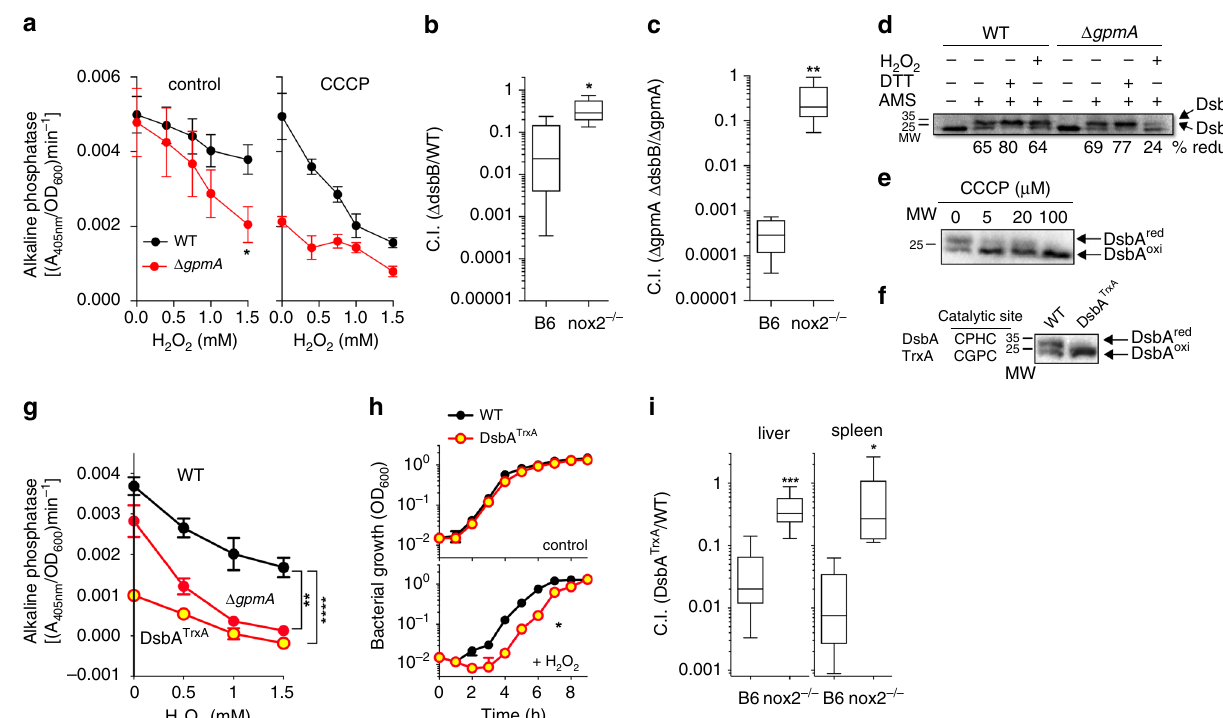
Fig. 4 Glycolysis facilitates folding of oxidized periplasmic proteins. a Alkaline phosphatase in Salmonella treated for 30 min with either 400 μ M H 2 O 2 or 20 μ M CCCP. Mean± SD; N = 6. b , c C57BL/6 (B6) and nox2 − / − mice were infected with 500 CFU each of the indicated Salmonella strains, and the competitive index determined 3 days later. b N = 5, c N = 8. d – f Western blots of AMS-derivatized DsbA-3xFLAG proteins in WT, Δ gpmA or DsbA TrxA Salmonella grown aerobically in MOPS-glucose media. Where indicated, the bacteria were treated for 5 min with 10 mM DTT, 1 mM H 2 O 2 or CCCP. The percentage of reduced DsbA is the mean from three independent experiments as calculated by densitometry. g Alkaline phosphatase was measured as described in a. Mean± SEM; N = 4. h Aerobic growth of Salmonella in MOPS-glucose media in the presence or absence of 100 μ M H 2 O 2 . Mean ± SD; N = 4. i Competitive index of the indicated strains in C57BL/6 and nox2 − / − mice 3 days after i.p. inoculation. N = 10. Data in a and h were analyzed by paired, one-tail t -test; data in b, c, i were analyzed by unpaired, one-tail t -test. Data in g were analyzed by one-way ANOVA, df = 11, F = 5.6. *, **, ***, **** p < 0.05, 0.01, 0.001, 0.0001, respectively. All measurements were taken from distinct samples. Whiskers in box plots represent minimal to maxima; 25th and 75th percentiles and median are also represented. Source data are included in Source Data fi